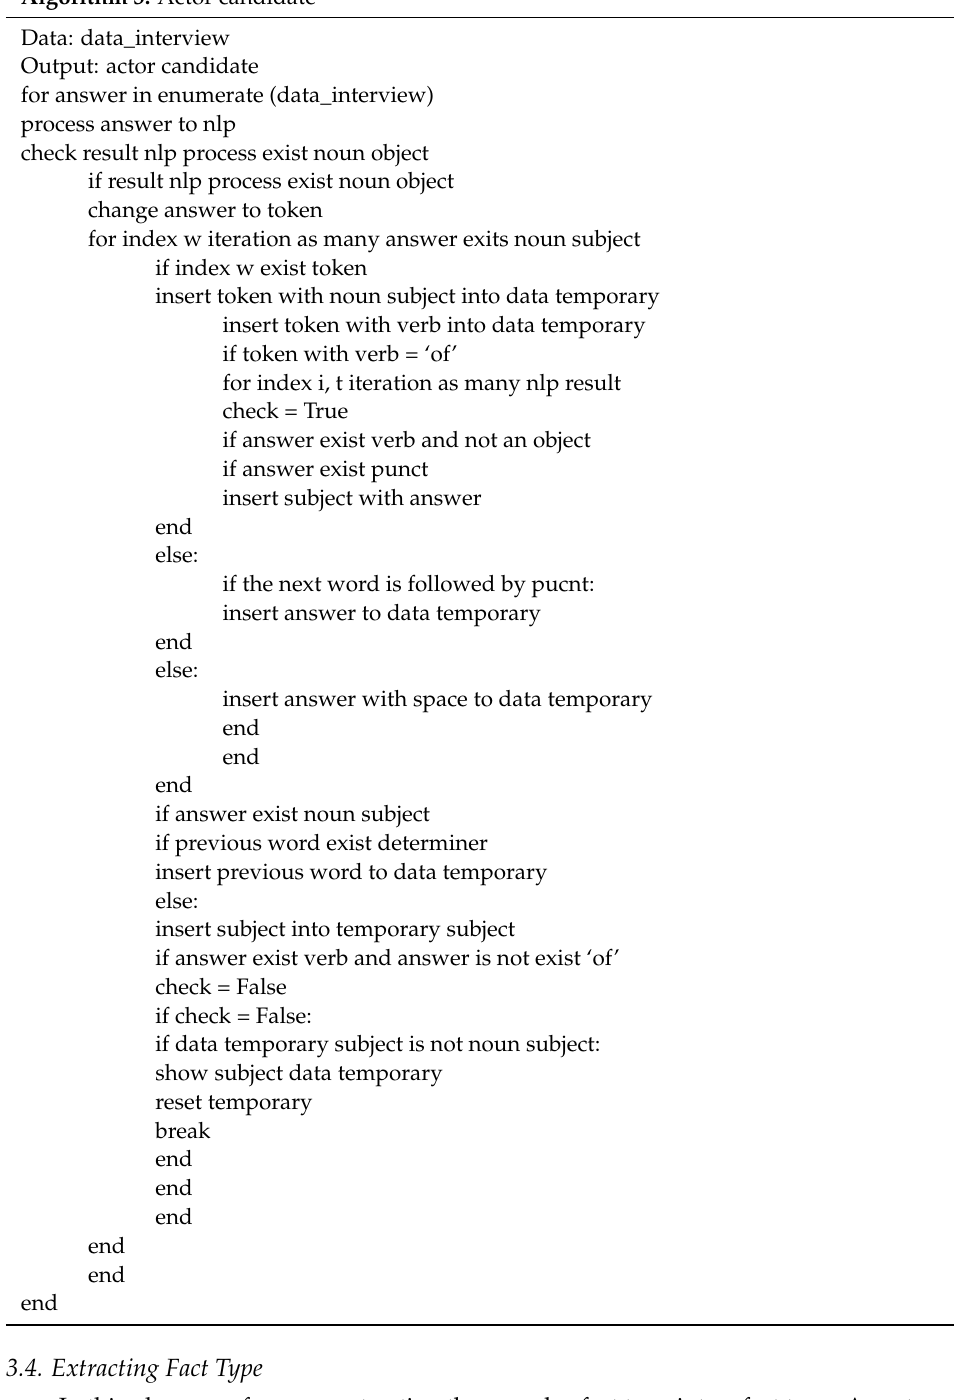
Algorithm 3. Actor